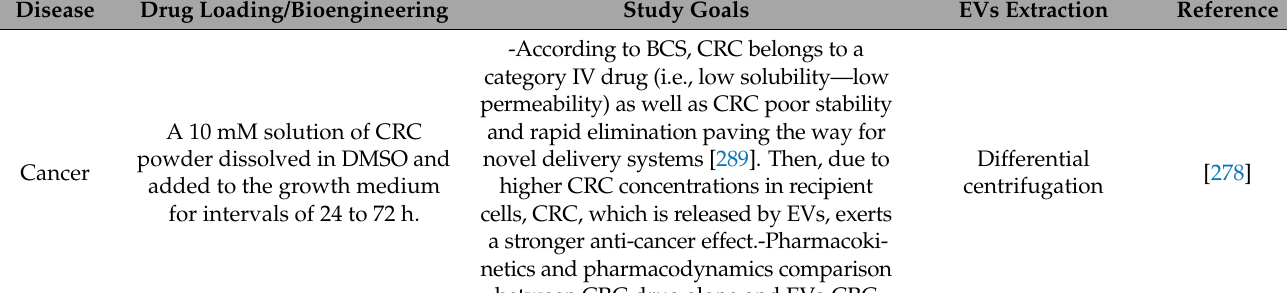
Table 2. Overview of EVs formulations evaluated in in vivo experiments.